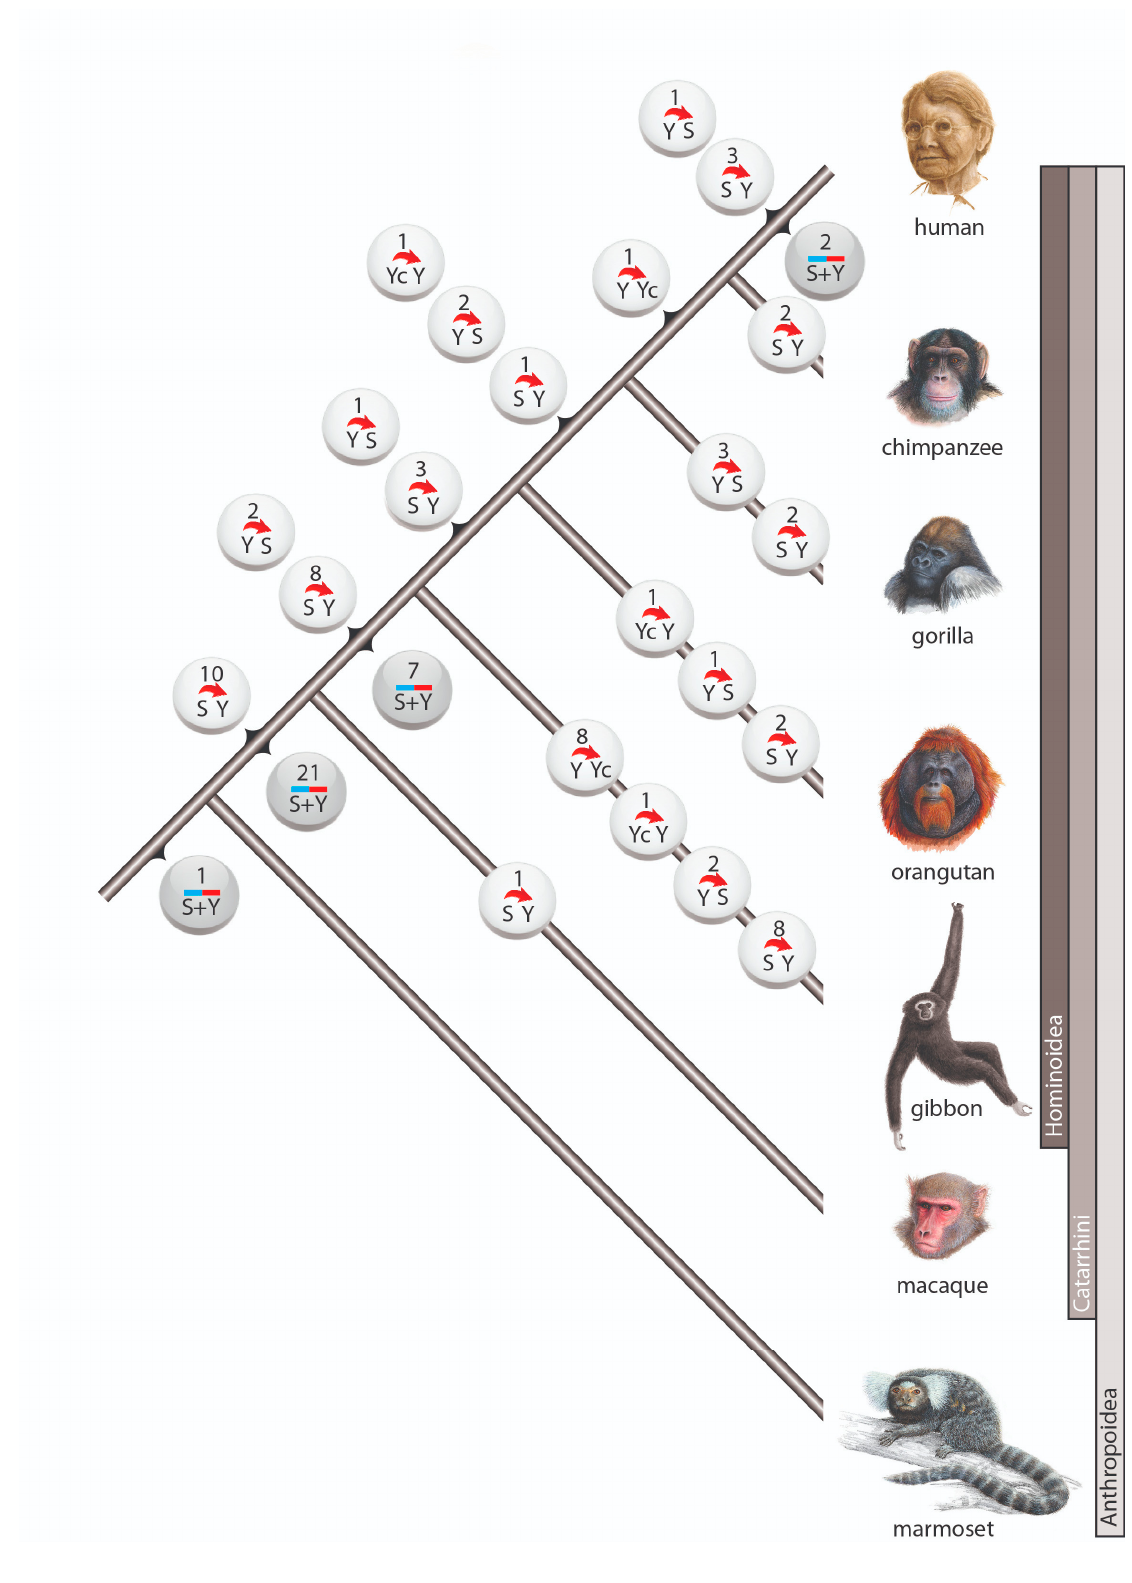
Figure 2. Gene conversion in primates. Circles represent incidences of gene conversion including the number of such occurrences and their direction. White circles are incidences in which the ancestral Alu element and the direction of conversion were reconstructed. Gray circles represent incidences with unidentifiable conversion direction. The 3 cases with complex scenarios are not